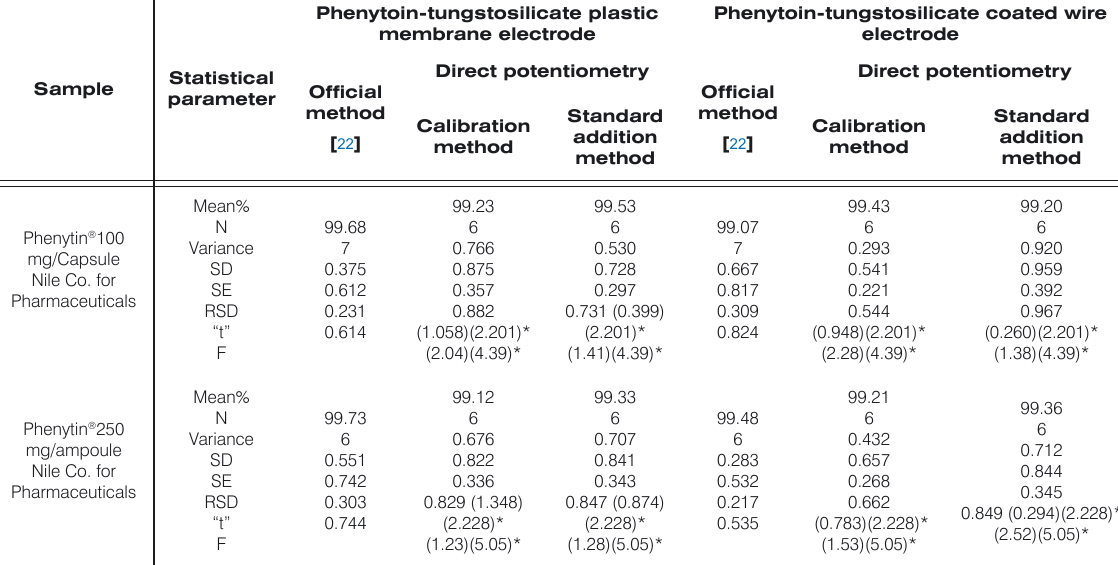
Table 6. Comparative analytical results of the proposed and official method for the tested drug in some pharmaceutical